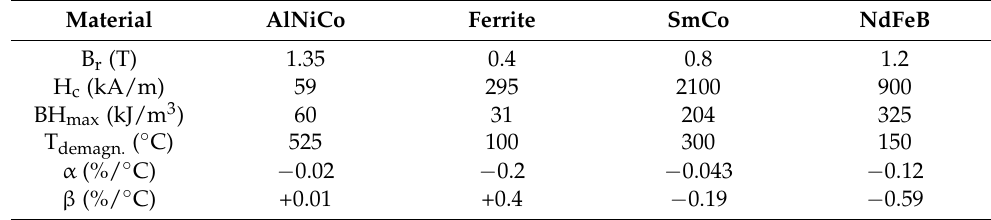
Table 2. Comparison of typical PM materials